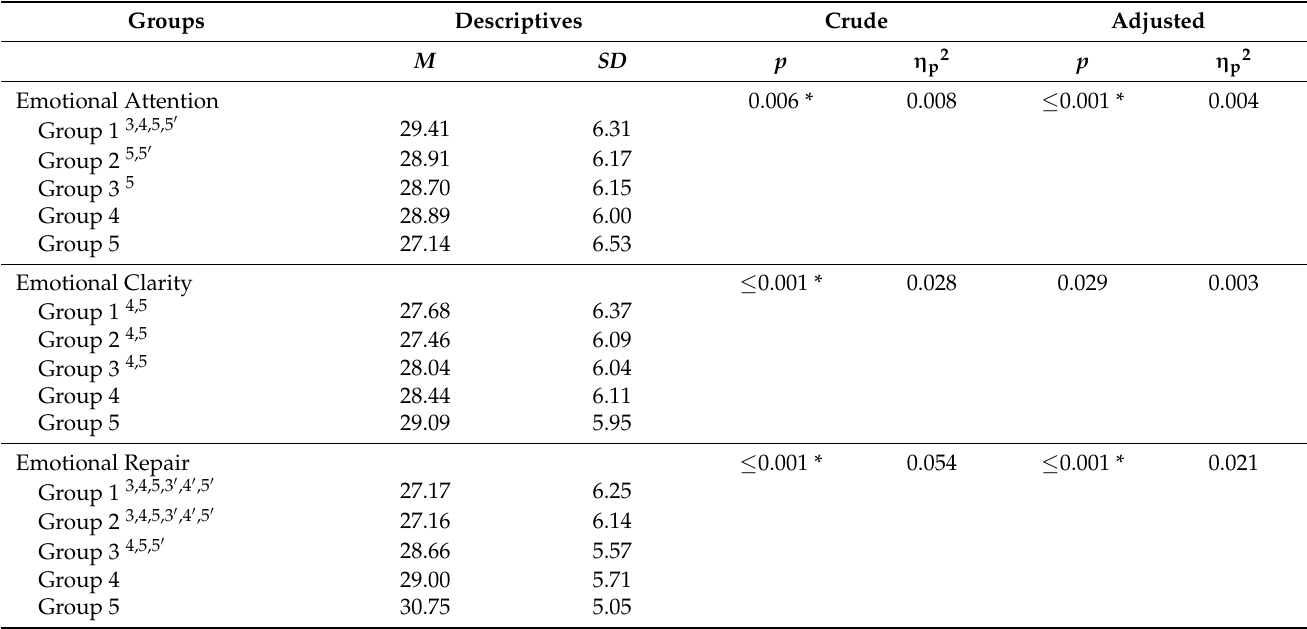
Table 3. Differences among groups studied in the emotional intelligence dimensions (EA, EC, and